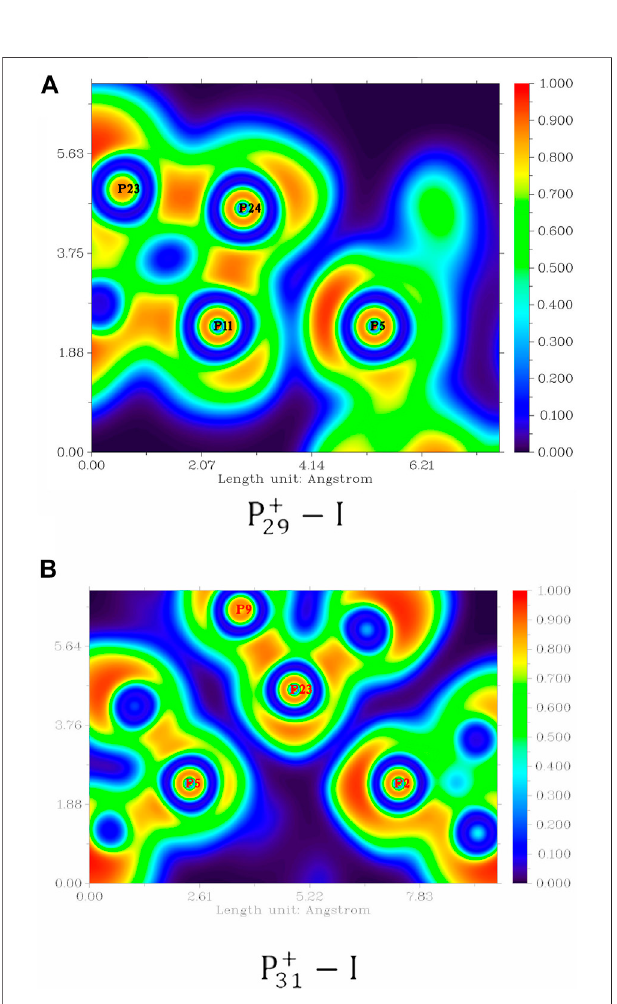
FIGURE 7 | ELFs of (A) P + 29 − I and (B) P + 31 − I.